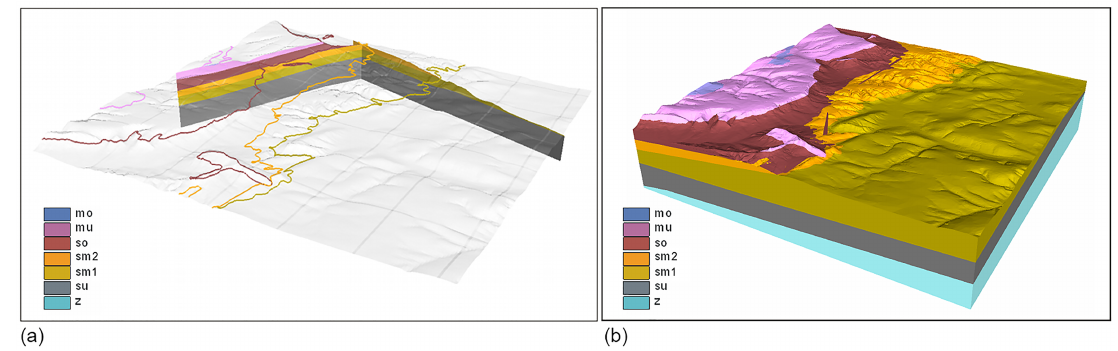
Figure 4. Geological units in the test site at Ebergötzen, elevation registered with the DEM data (b) and the geological cross sections (a) derived from Ehlbracht (2000): Upper Muschelkalk (mo), Lower Muschelkalk (mu), Upper Buntsandstein (so), Middle Buntsandstein 2 (sm2), Middle Buntsandstein 1 (sm1), Lower Buntsandstein (su) and Zechstein